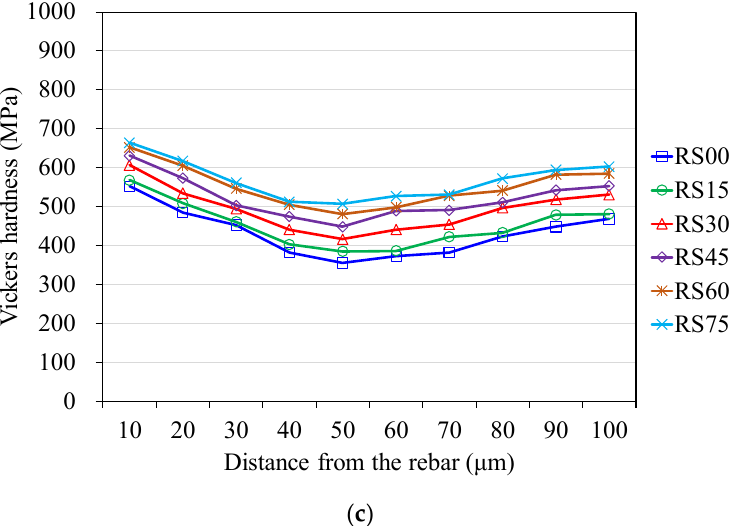
Figure 4 . Measured Vickers hardness of recycled aggregate concrete at ages of ( a ) 28 days, ( b ) 56 days and ( c ) 91 days.